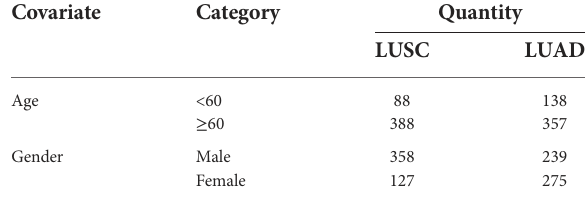
TABLE 2 LUSC and LUAD clinical